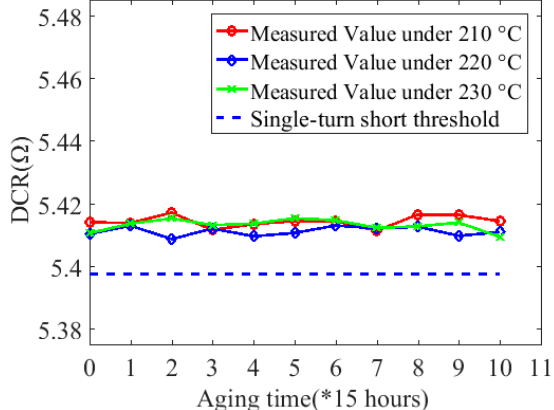
Figure 16. DCR measurement results under 210 °C, 220 °C, and 230 °C.